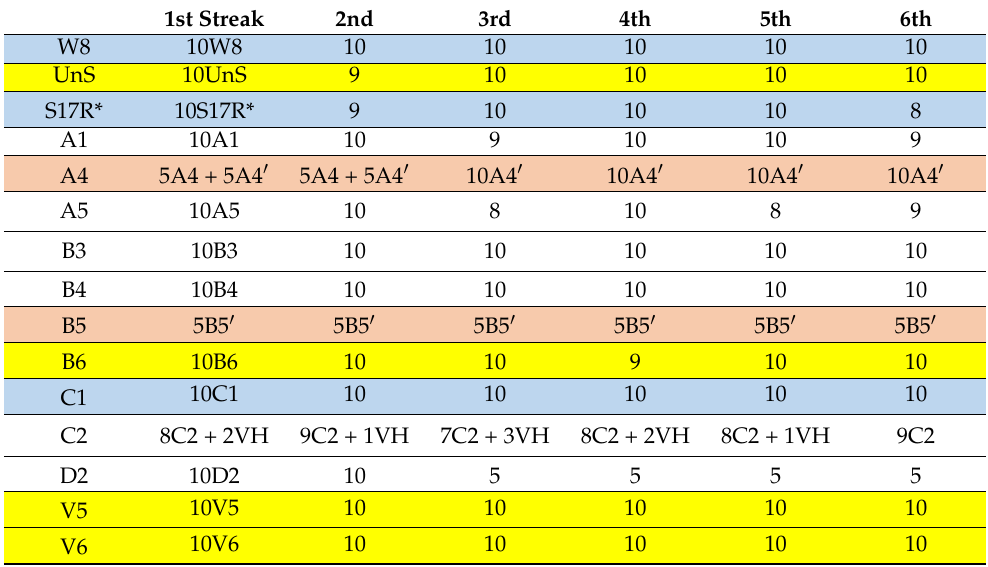
Table 2. Serial propagation with Hsp104 T160M